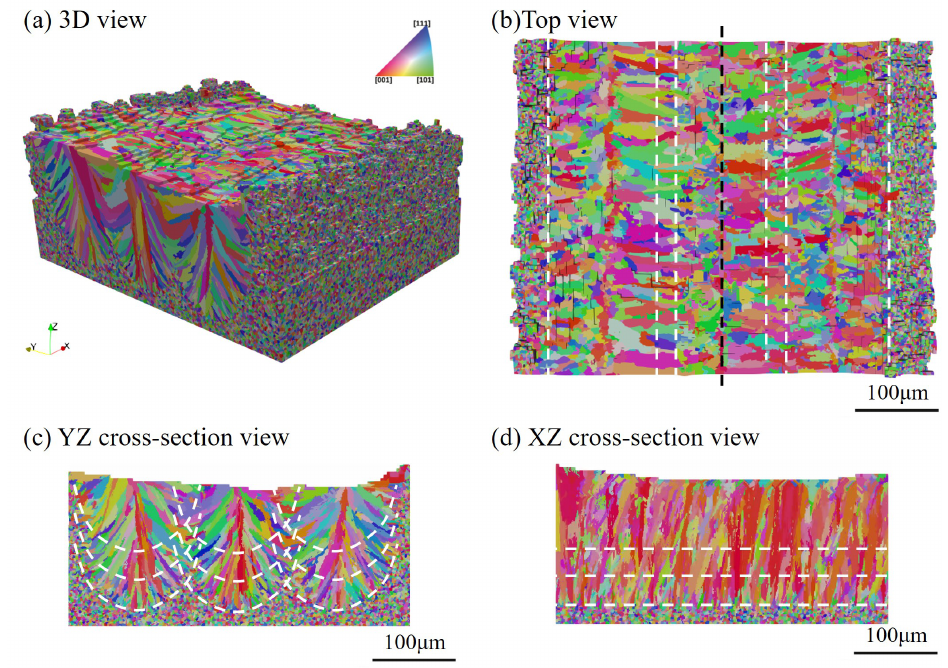
Figure 17. Microstructure simulation results for three-layer and three-track case: ( a ) 3D view of the result, ( b ) top view, ( c ) transverse cross-section map, and ( d ) longitudinal cross-section map, where white dotted lines represent the boundary of the fusion zone, and black dotted lines represent the locations of the